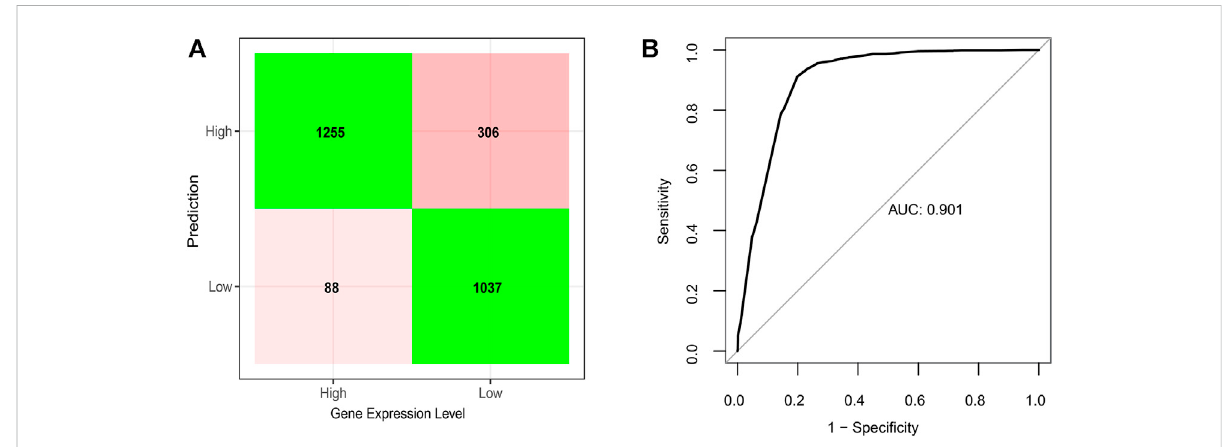
FIGURE 5 Elastic net regression model on gene expression predicted given the status of G4 formation and location, CGI, enhancer, super-enhancer, and chromatin status. (A) Confusion matrix of prediction results based on the fi nal regression model on testing dataset. (B) Corresponding ROC curve with AUC score of the regression